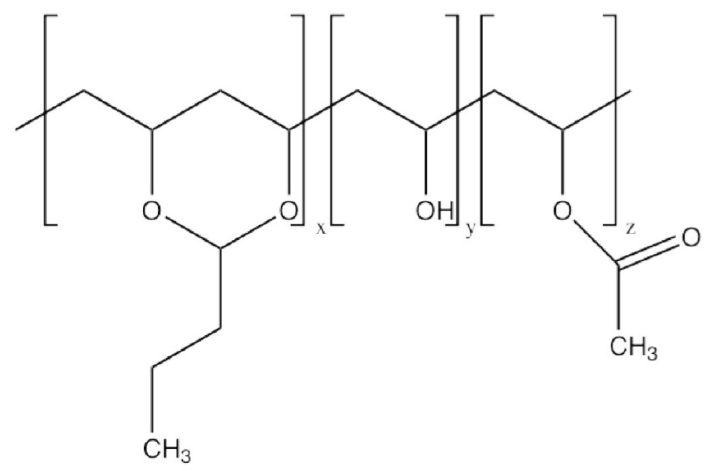
Figure 1. Chemical structure of poly(vinyl butyral) (PVB). For the PVB under investigation, the molar fractions of the vinyl butyral (x), vinyl alcohol (y), and vinyl acetate (z) units are 0.55–0.57, 0.41–0.45, and 0–0.02, respectively.